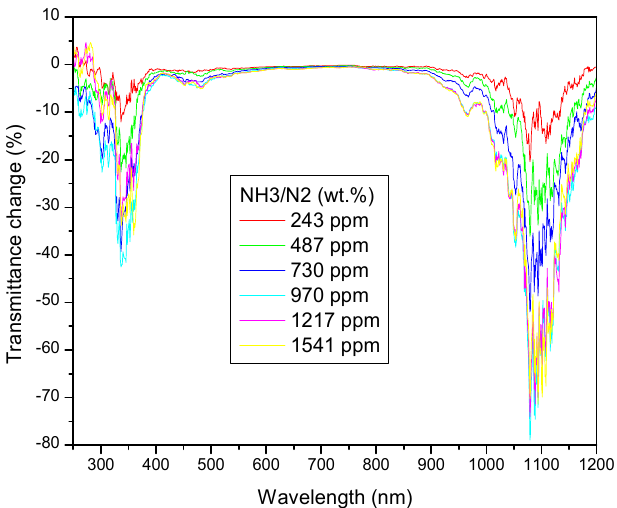
Figure 6. Absolute changes in the spectral transmittance observed under subsequent expositions to NH 3 /N 2 gas mixtures of the indicated composition. Changing from absolute to the relative transmittance ( ∆ T rel = ∆ T abs /T N2 ), the details of spectral changes become even more apparent (Figure 7). The split of the short-wavelength transmittance band is well resolved, with the first stronger extreme of transmittance change at ca. 350 nm, and the second one at ca. 480 nm. At the long-wavelength side, a broad extreme dominates, centered on about 1100 nm, accompanied by a weaker side-peak at ca. 950